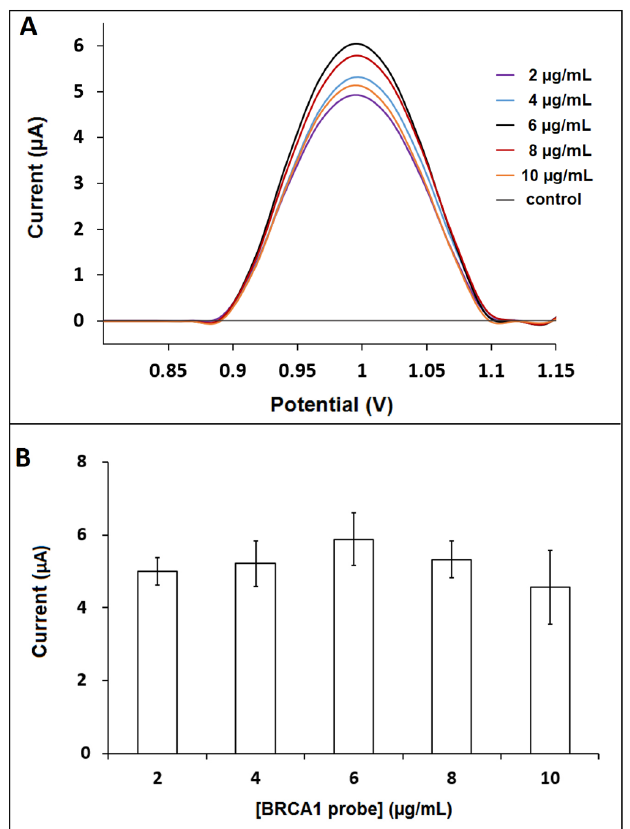
The BRCA1 probe concentration was further optimized by testing five probe concen- trations (from 2 to 10 µ g/mL) (Figure 7). For this purpose, the solution-phase hybridization between the BRCA1 probe and the BRCA1 target was performed. After hybridization, the highest guanine oxidation signal was measured as 5.88 ± 0.73 µ A (RSD %, 12.41 %, n = 3), in the case of the 6 µ g/mL BRCA1 probe (Figure 7).